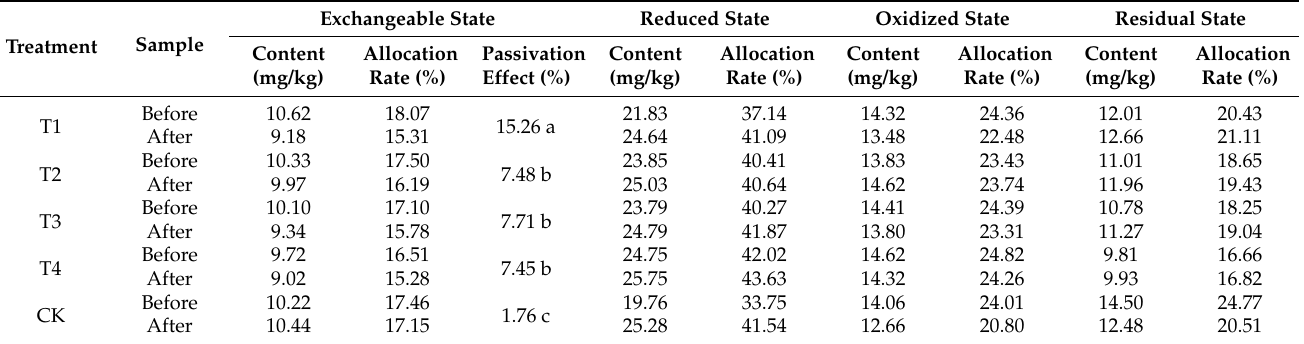
Table 4. Effect of biochar application on speciation of Zn during biogas residue